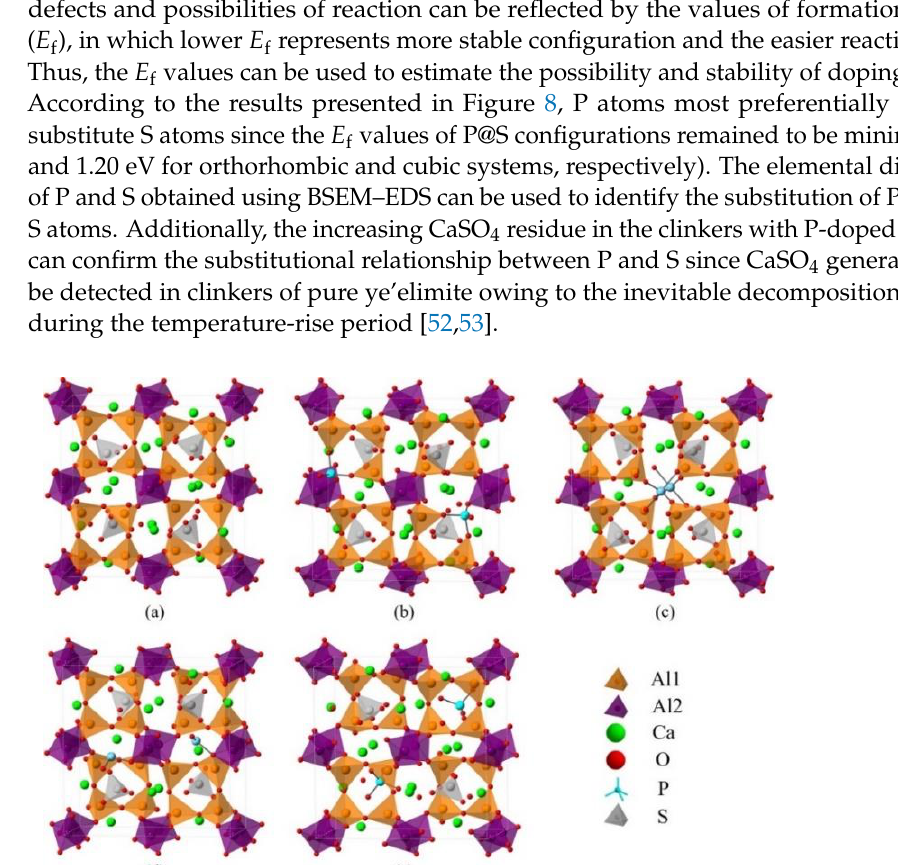
Table 3. RQPA results (wt.%) for clinkers containing P-doped ye’elimite.